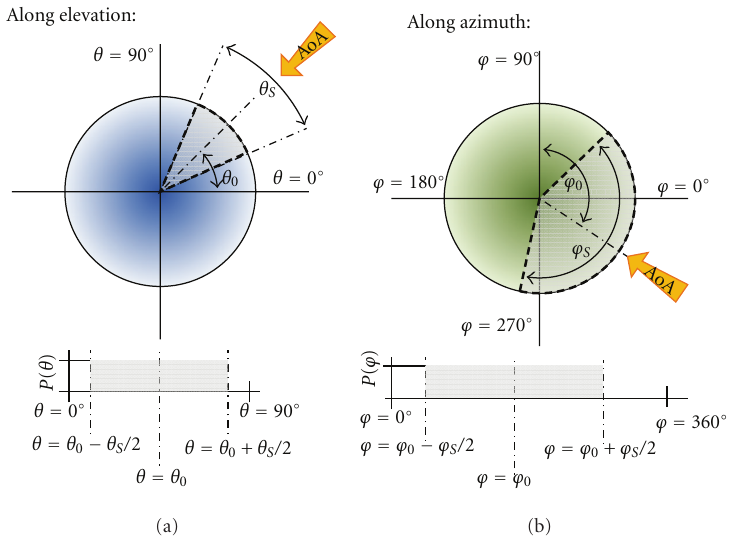
Figure 2: Schematic representation of mean AoA and AS along elevation and